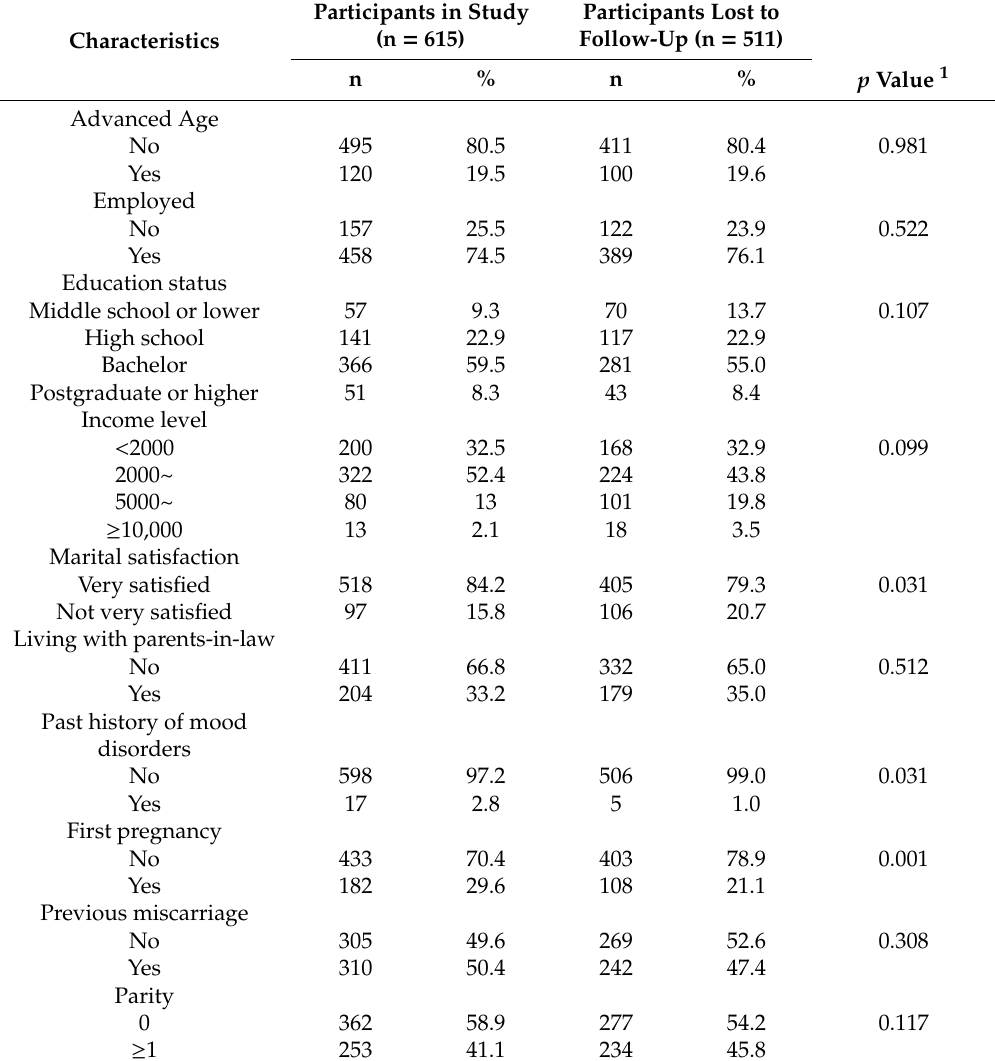
Table 1. Comparison of baseline characteristics between the participants with complete data and those lost to